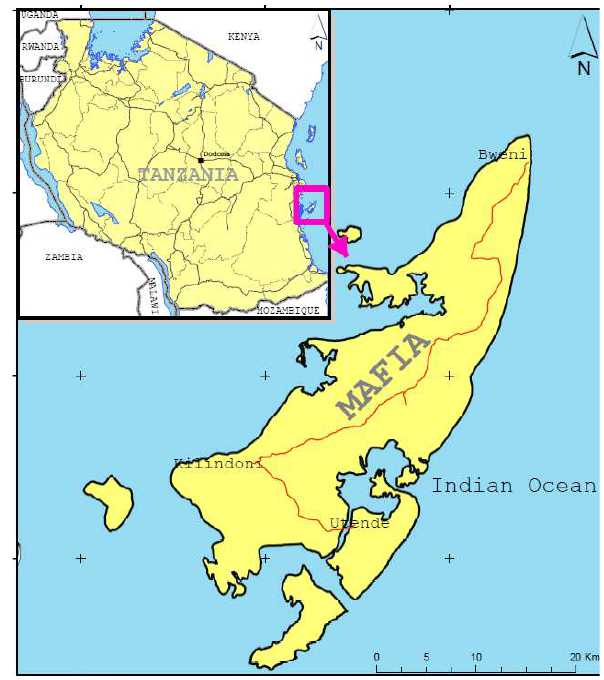
Figure 3. Mafia Island Location Map